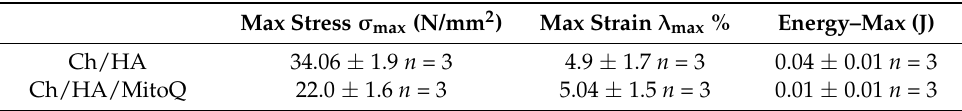
Table 2. Mechanical properties of Ch/HA and Ch/HA/MitoQ